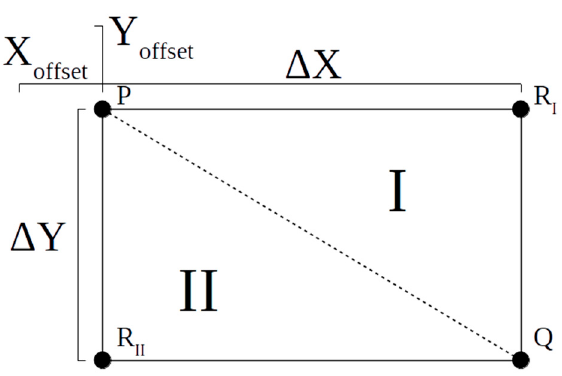
Figure 6. A sketch defining the regions and points used for the 3-D linear interpolation.